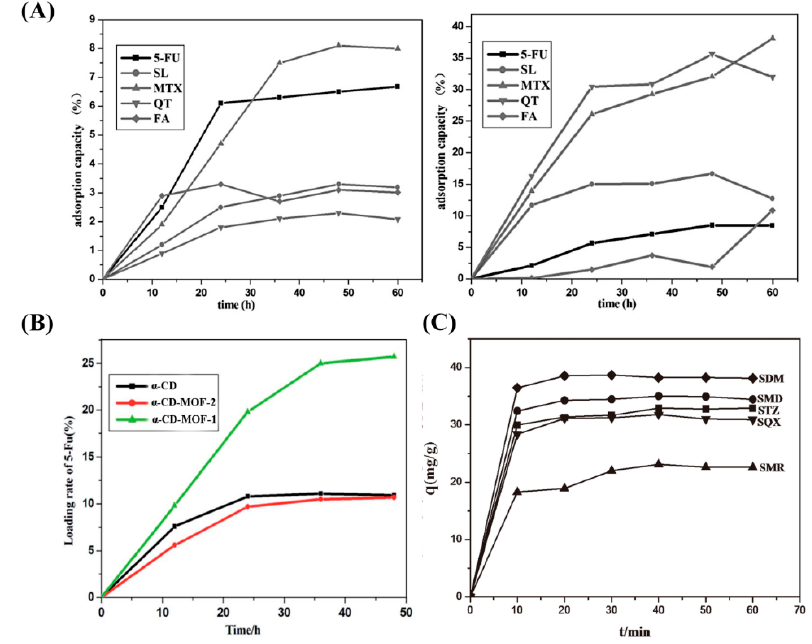
Figure 4. Time dependence of five drug adsorption capacities in α -CD (left) and Na- α -CD-MOF (right) ( A ), 5-Fu drug-loading rate in α -CD and two α -CD-MOFs ( B ), and four sulfonamide drug adsorption rates in γ -CD-MOF ( C ). Reprinted with permission from [64,69,99], copyright RSC, 2016; Elsevier, 2017; and Elsevier, 2018.